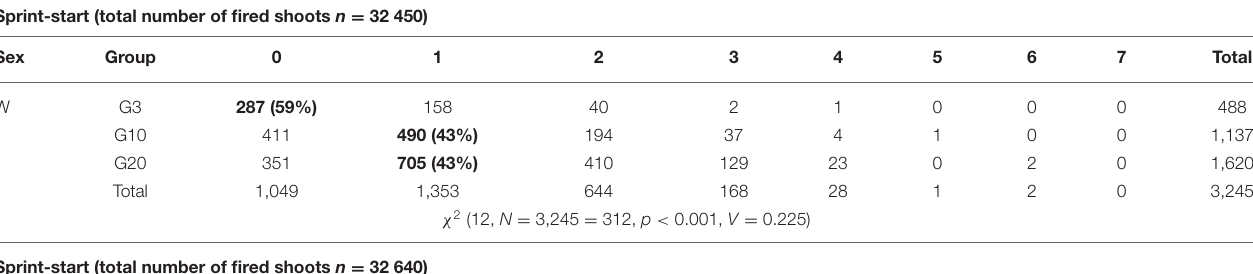
TABLE 3 | Frequency of missed targets out of the total number fired shots in sprint and individual competitions in IBU WC 2002/2003–2018/2019. Sprint-start (total number of fired shoots n = 32